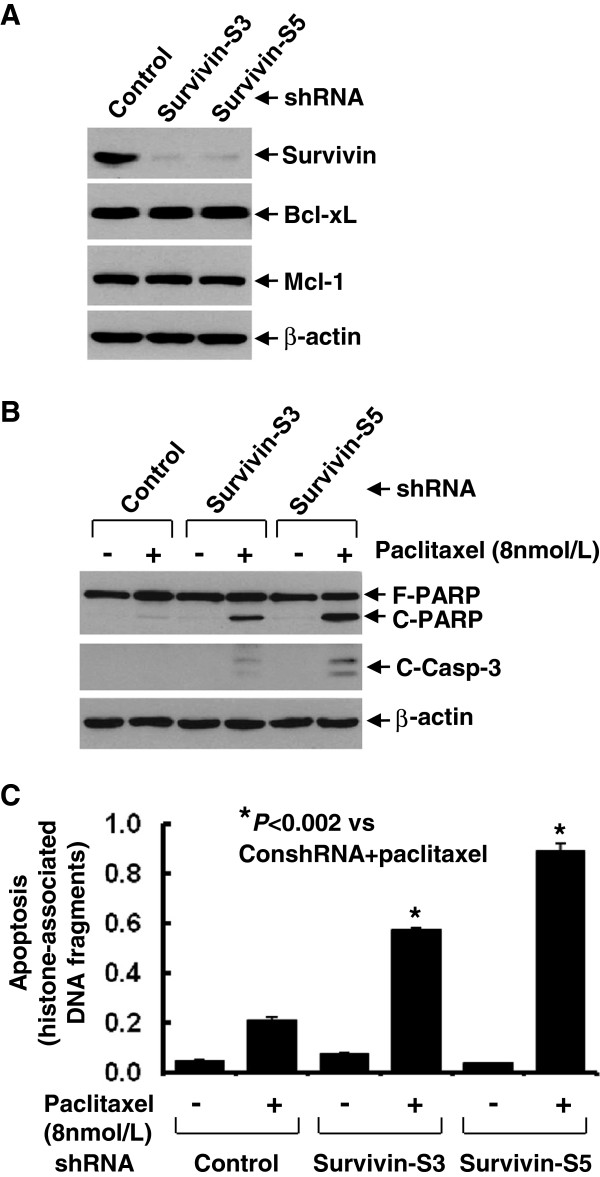
Specific knockdown of Survivin expression with shRNA significantly promotes paclitaxel-induced apoptosis in a trastuzumab-resistant breast cancer cell line. BT474-HR20 cells infected with lentivirus containing either control shRNA (ConshRNA) or Survivin shRNA (Survivin-S3, Survivin-S5) were subjected to the following experiments. (A) Western blot analyses of Survivin, Bcl-xL, Mcl-1, or β-actin. (B and C) The cells were then untreated, or treated with paclitaxel (8 nmol/L) for 24 h. The cells were collected and subjected to (B) western blot analyses of poly(ADP-ribose) polymerase (PARP), cleaved caspase-3, or β-actin; or to (C) apoptosis ELISA. Bars represent SD.